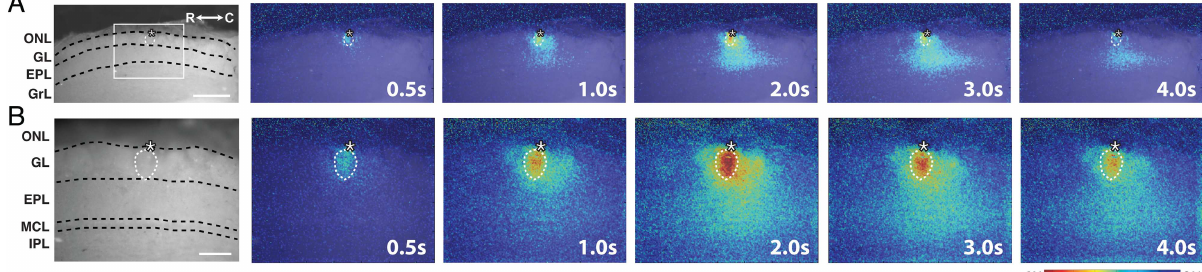
PLOS ONE | DOI:10.1371/journal.pone.0165342 November30,